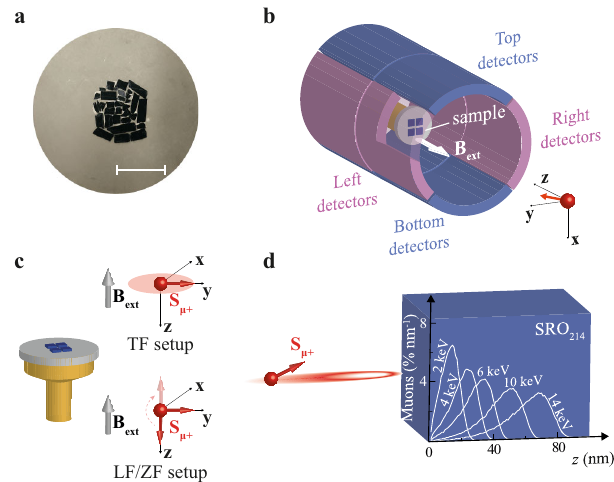
Fig. 1 Low-energy μ SR setup for measurements on SRO 214 single crystals. a SRO 214 crystals cleaved and glued onto a Ni-coated aluminium plate to form a mosaic for the LE- μ SR measurements. The scale bar corresponds to a length of 2 cm. b Experimental LE- μ SR setup with applied fi eld vector B c -axis of SRO 214 ext perpendicular to the sample (i.e., along the coinciding with the axis z of our orthonormal reference-axes system) and arrays of positron detectors used to count muon decay events. The schematic cut-out allows viewing the sample inside the detectors. c LE- μ SR measurement con fi gurations for different orientations of the initial muon spin polarization vector S μ + : S μ + perpendicular to the applied fi eld vector B ext and precessing in the xy -plane of our reference-axes system as indicated by the shadowed red circle (transverse fi eld, top) or S μ + collinear to B ext (longitudinal fi eld or zero fi elds with B ext = 0, bottom). d Muon implantation pro fi les in SRO 214 simulated for a few representative implantation